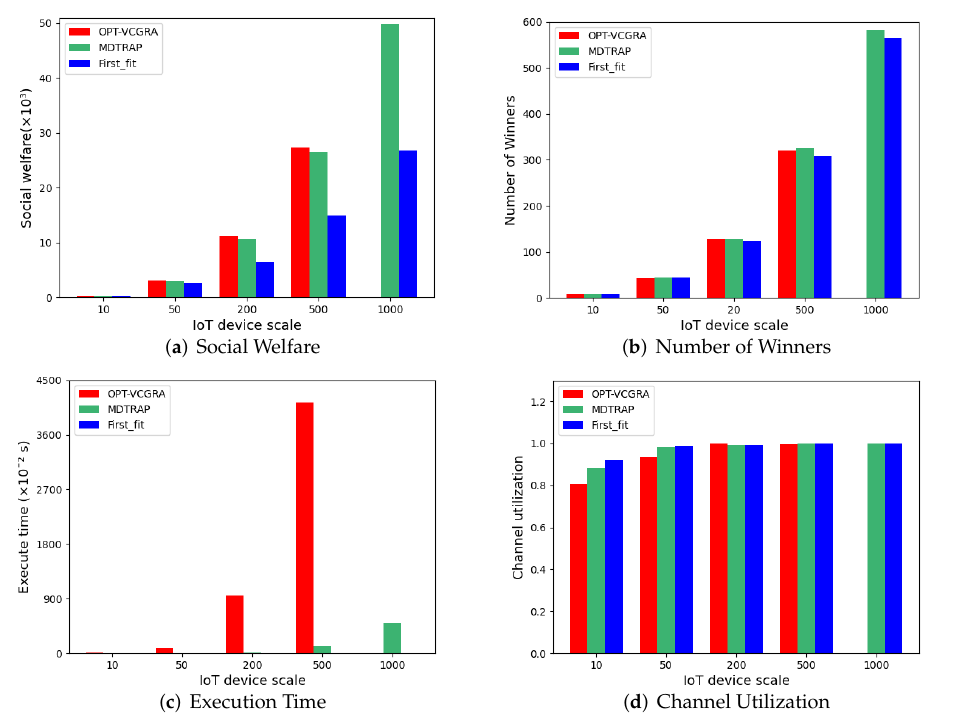
Figure 5. Social welfare, number of winners, execution time and channel utilization under different numbers of IoT